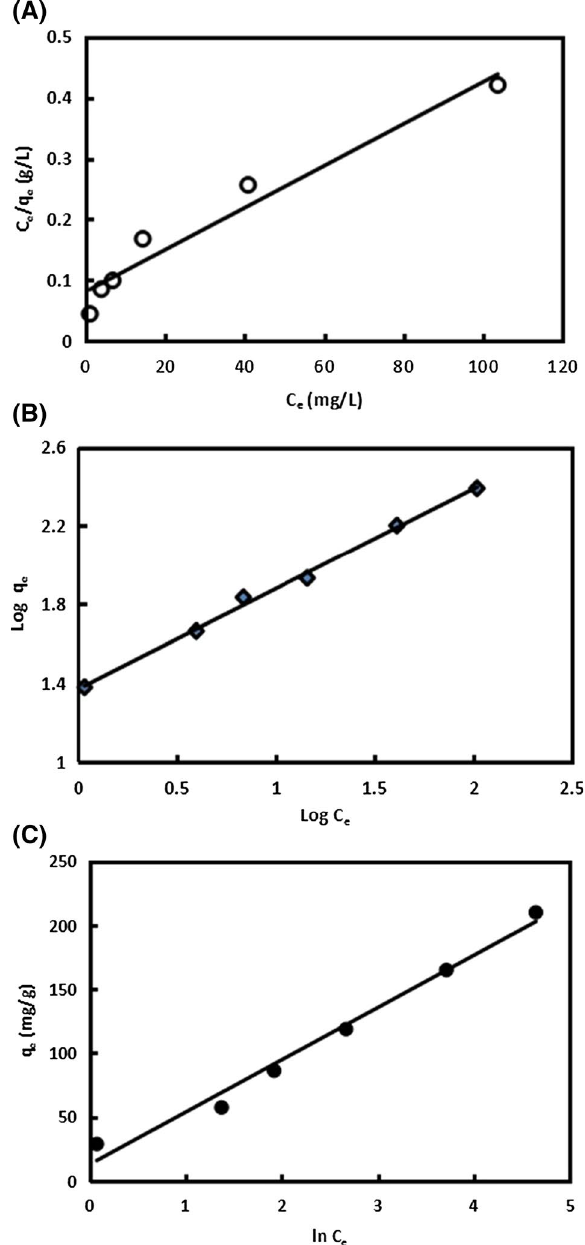
Fig. 7 Effect of contact time and pH (inset) on the removal of 2,4,6- TCP onto CSSS-AC